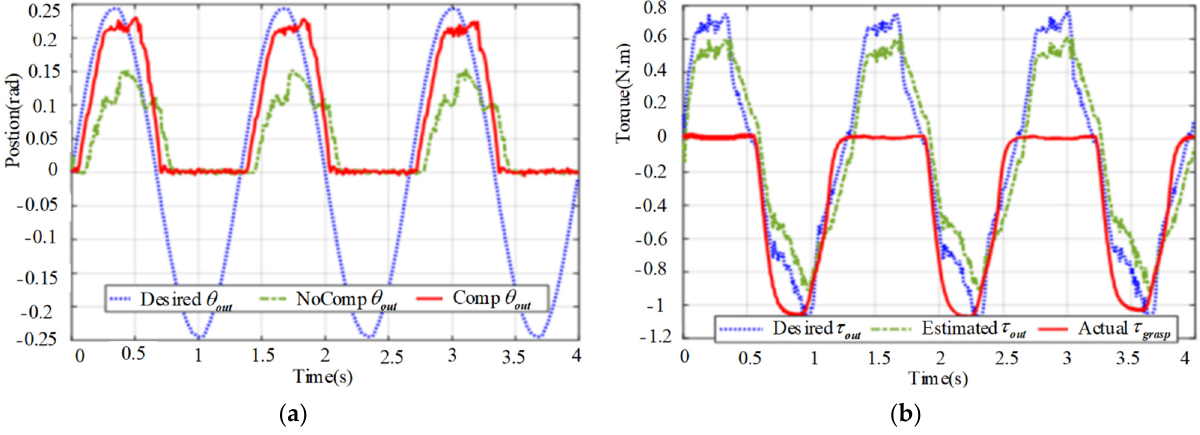
Figure 12. Output displacement and torque curves of the distal grasper with position compensation: ( a ) Output displacement of the distal grasper with position compensation; ( b ) Output torque of the distal grasper with position compensation.